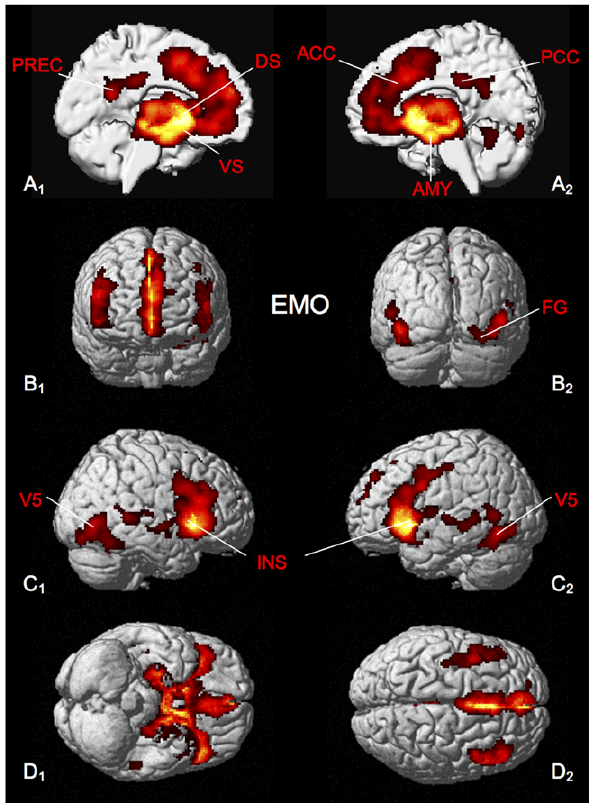
Figure 2. Significant results of the ALE meta-analysis of emotional processing tasks (EMO). All results are displayed on the left and right lateral surface view, the anterior/posterior and dorsal/ ventral view of the MNI single subject template. ACC: anterior cingulate cortex, AMY: amygdala, DS: dorsal striatum, FG: fusiform gyrus, INS: insula cortex, PREC: precuneus, PCC: posterior cingulate cortex, VS: ventral striatum. doi:10.1371/journal.pone.0030920.g002 PLoS ONE |